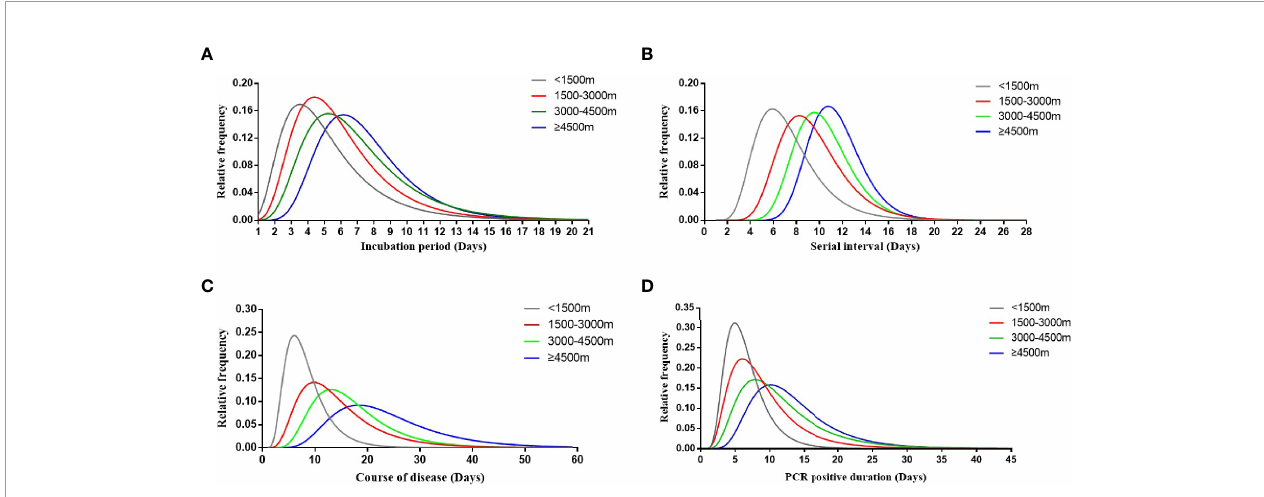
FIGURE 2 | Key time-to-event distributions. The estimated incubation period distribution (i.e., the time from infection to illness onset) is shown in (A) . The estimated serial interval distribution (i.e., the time from illness onset in successive cases in a transmission chain) is shown in (B) . The estimated course of disease (i.e., the time from illness onset to the disappearance of symptoms) is shown in (C) . The estimated PCR-positive duration (i.e., the time from the fi rst PCR positive to PCR negative) is shown in (D)